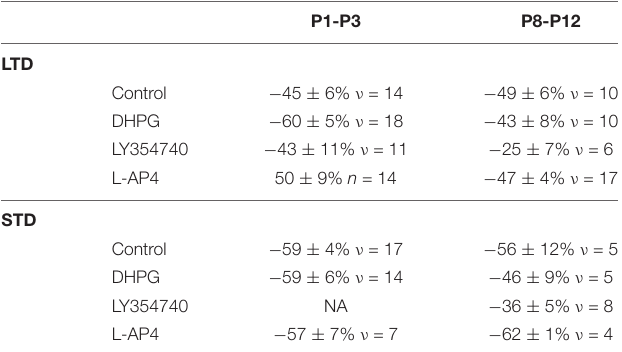
TABLE 3 | Magnitude in percentage of the depression reached during long term depression (LTD) or short-term depression (STD) in control condition and in the presence of the three different mGluR agonists for the two different developmental stages